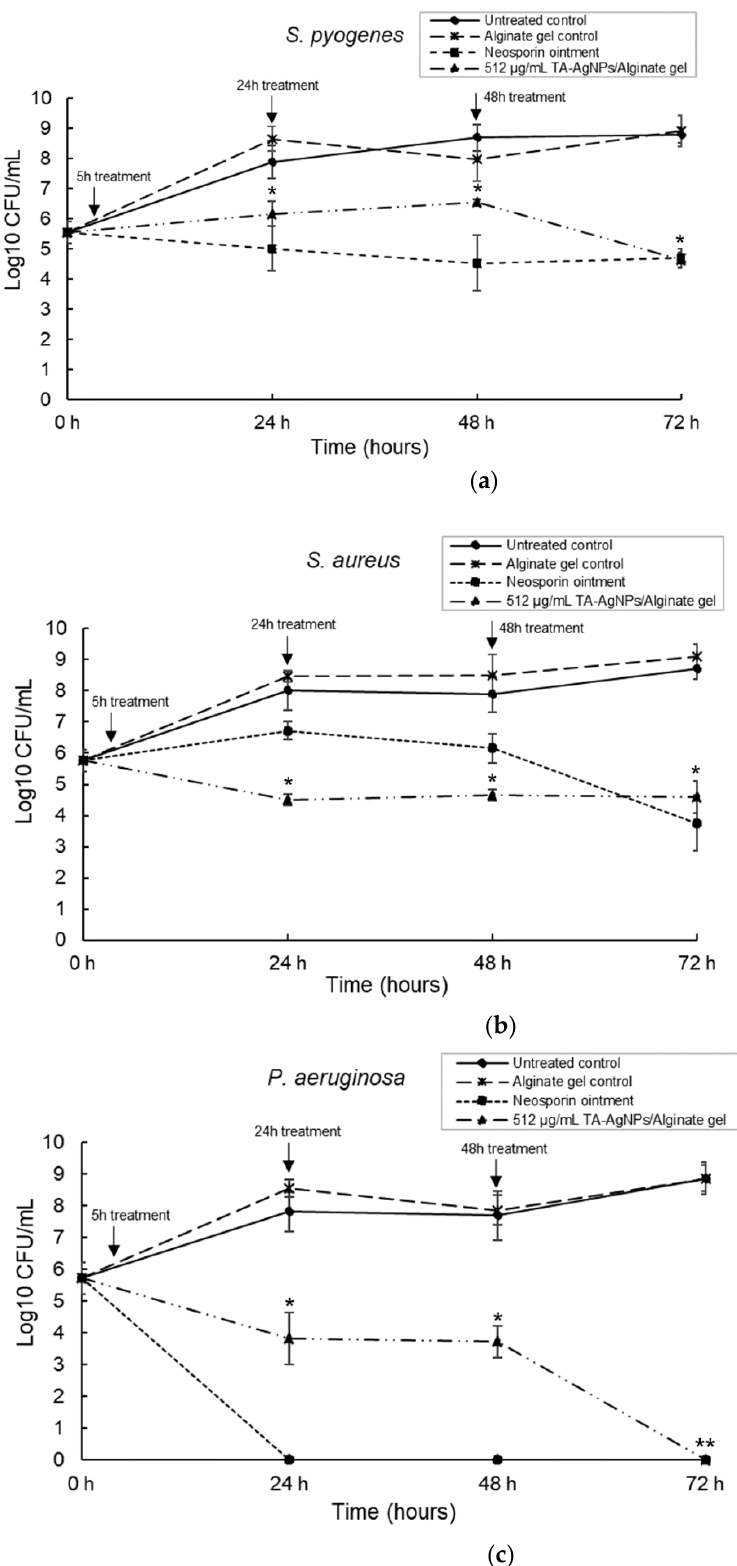
Figure 6. Multiple doses of TA-AgNPs/Alginate hydrogels treated at 5, 24 and 48 h (indicated by arrows) against a three-species biofilm: S. pyogenes ( a ); S. aureus ( b ); and P. aeruginosa ( c ).